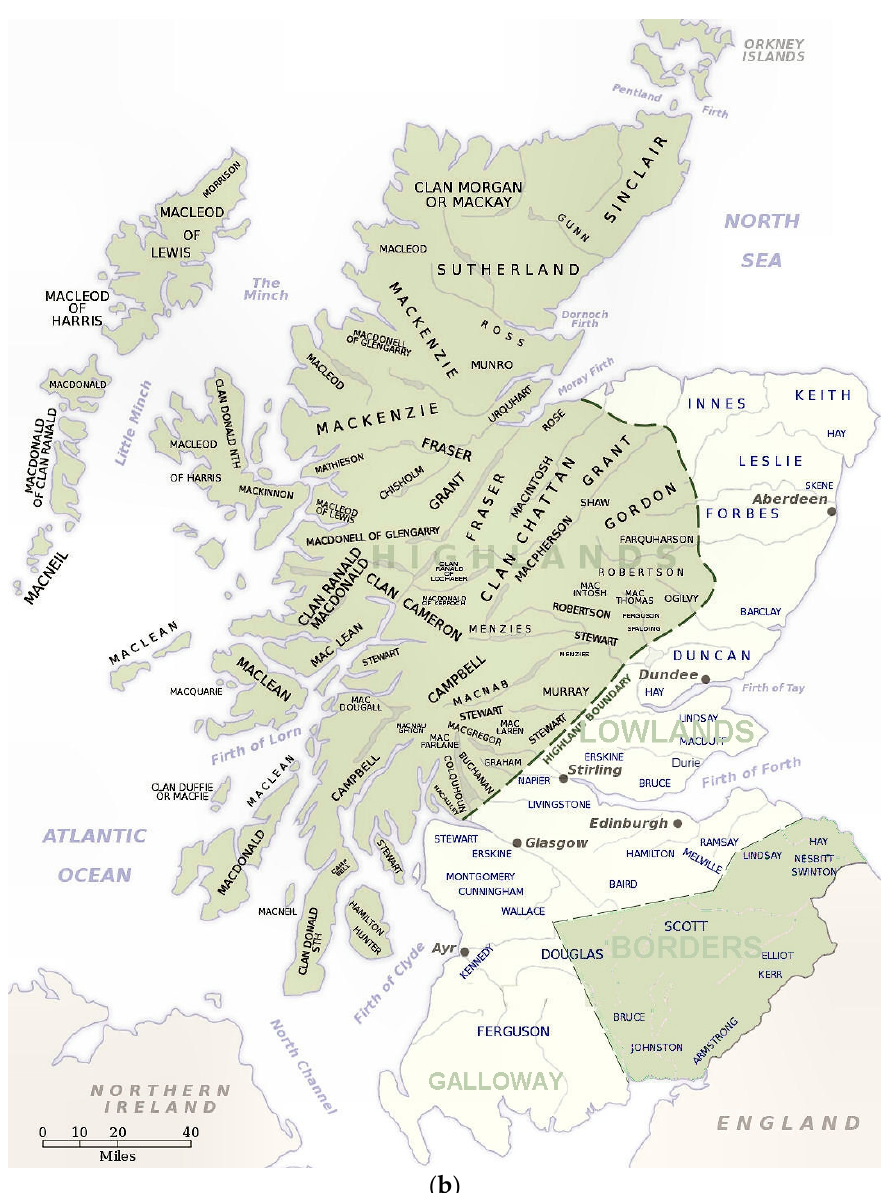
Figure 2. ( a ) The various ethnic incursions into Scotland at various times. ( b ) An approximate Clan and Family map, showing the geo-topographical division of Scotland into Highland and Islands (north and west), Lowlands (central and north-east), Borders (south and east) and Galloway (south- west). All such surname maps are a snapshot in time, and not complete, but give a rough indication of where Clans and Families consider their “heartlands” to be.